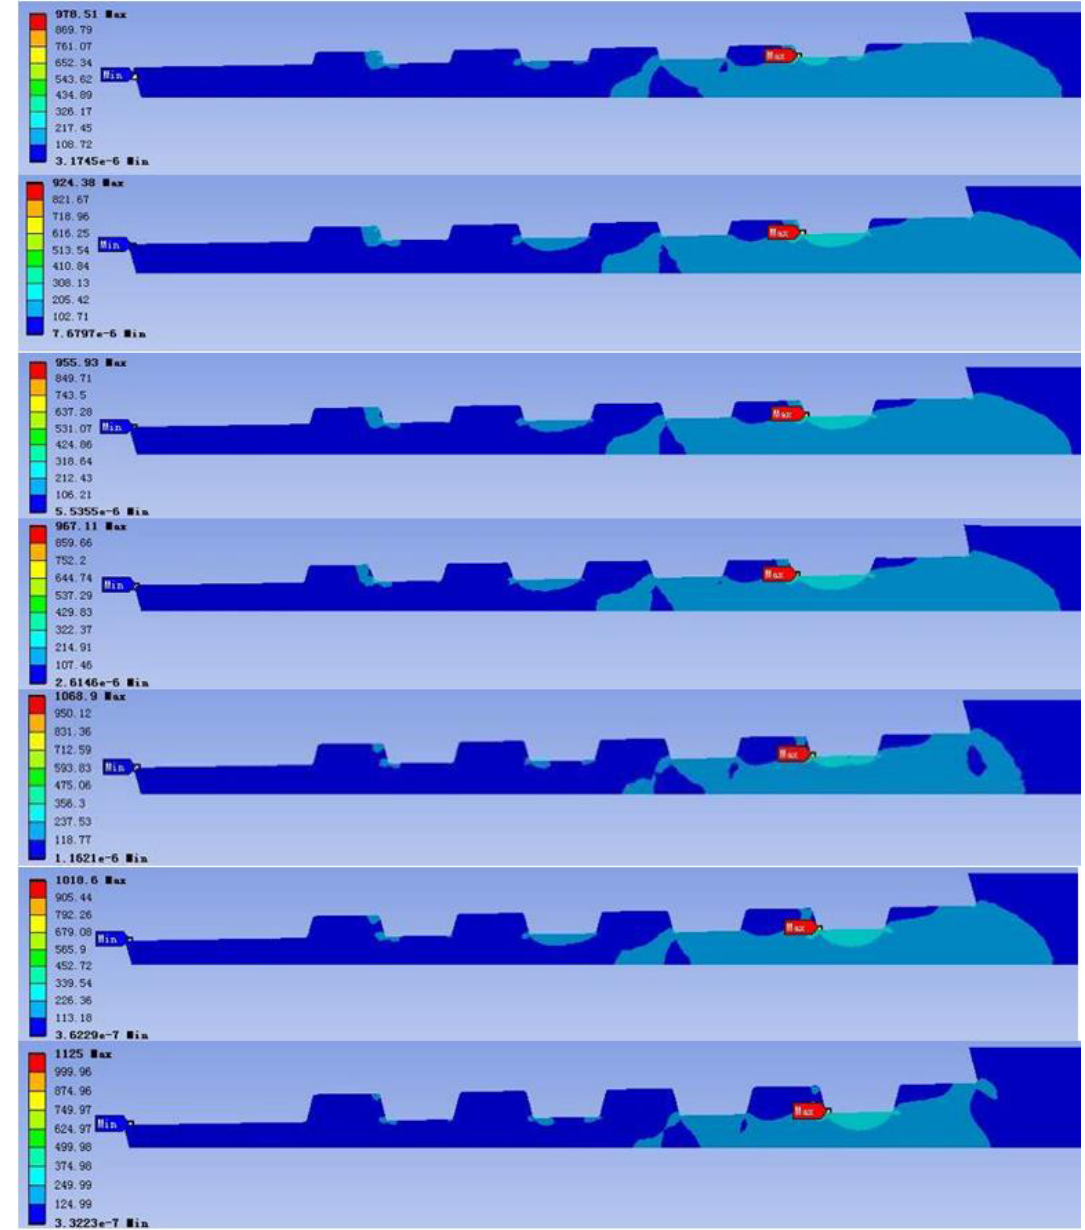
Figure 14. The stress nephogram of the external thread of the confining probe joint (the heights from top to bottom are 0.8, 0.9, 1.0, 1.1, 1.2, 1.3, and